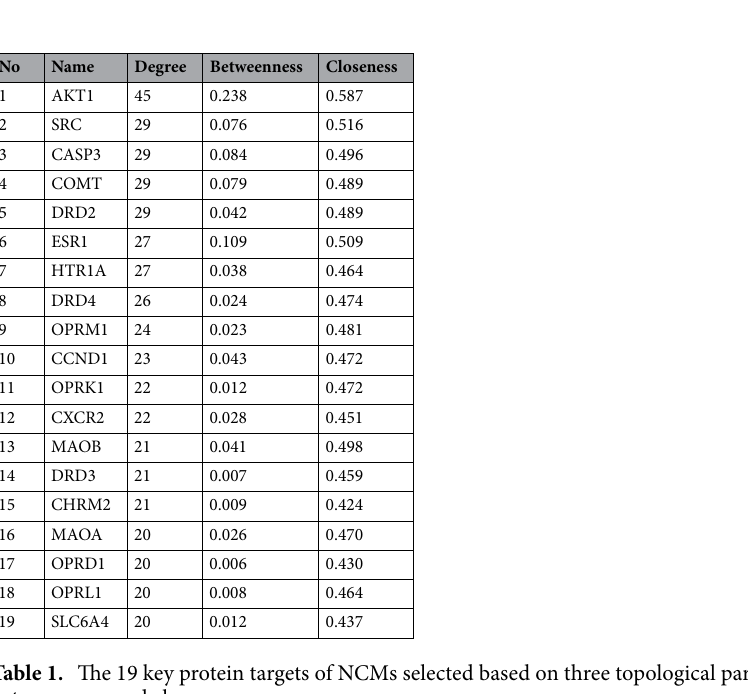
Table 1. The 19 key protein targets of NCMs selected based on three topological parameters, including degree, betweenness, and